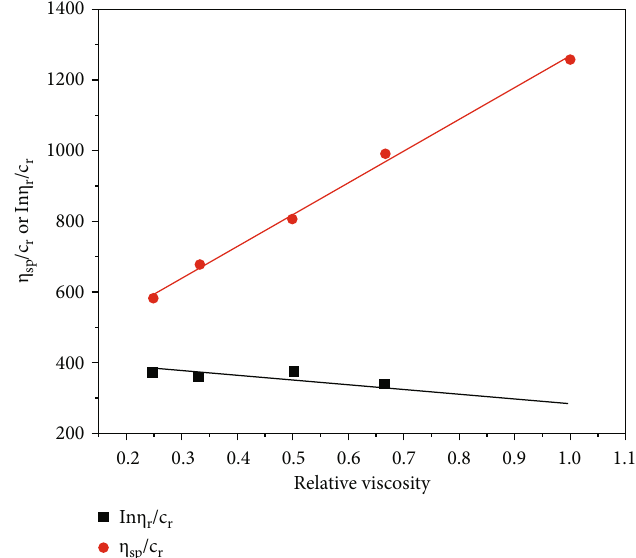
Figure 5: Relationship between η